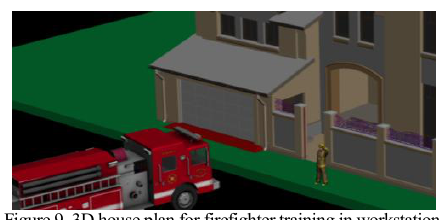
Figure 9. 3D house plan for firefighter training in workstation.